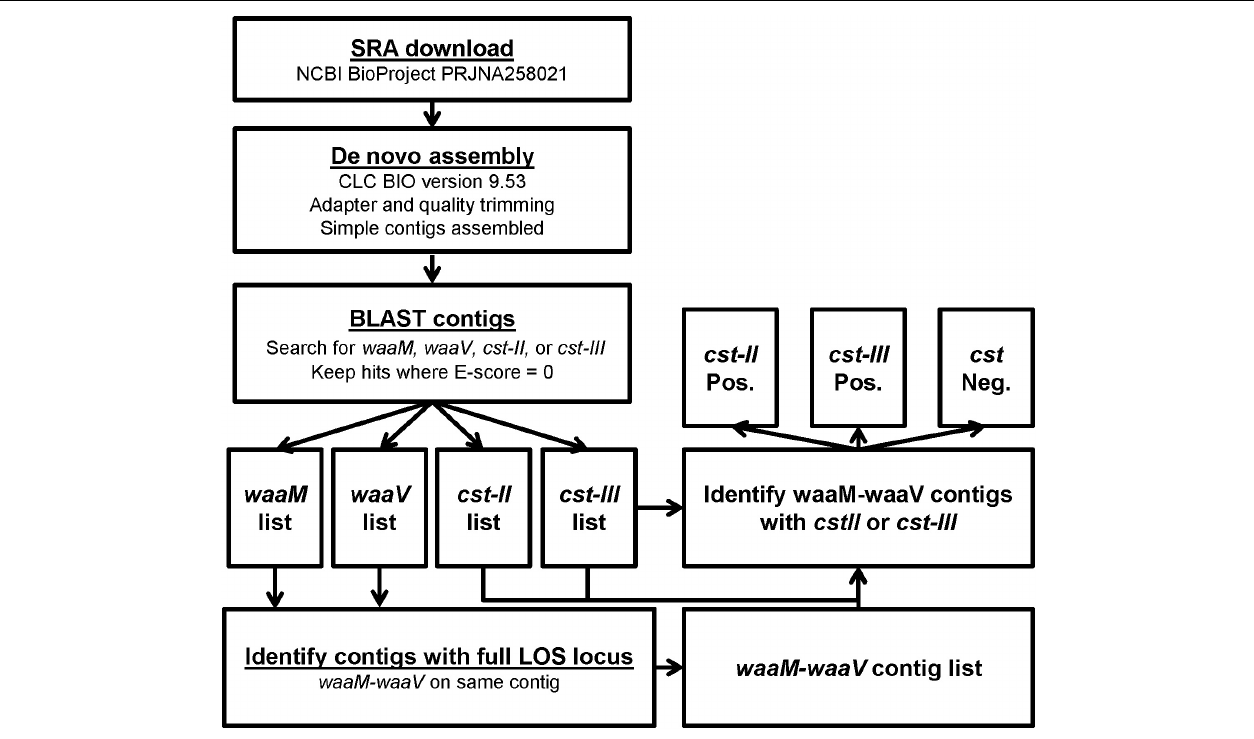
FIGURE 3 | Workflow for the determination of cst -type from GenomeTrakr SRA data. The strategy for identifying cst genes from SRA files starts with de novo assembly, followed by BLAST searches for the four genes of interest. To ensure that the variable genes of the LOS locus were present in an SRA, contigs were identified that contained both flanking genes, waaM and waaV . The waaM-waaV contigs were then determined to be cst-II positive or cst-III positive if the gene was found in the same contig, and cst negative if the genes were not detected.